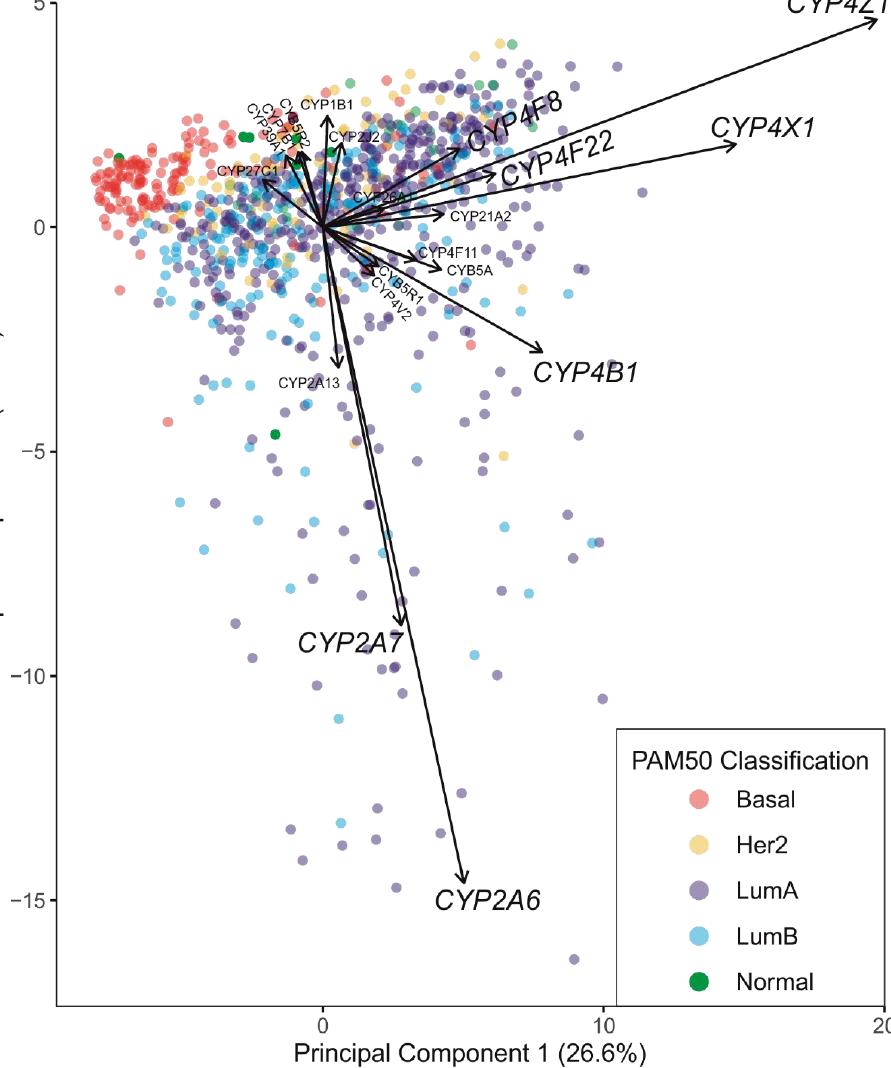
Figure 4. Variance in cytochrome P450 ( CYP ) gene expression (and their essential reductases) was analysed by principal component analysis (PCA). In the PCA biplot, each point represents an individual tumour from The Cancer Genome Atlas (TCGA) breast cancer cohort ( n = 935) coloured according to the PAM50 classification [122]. The size and direction of arrows assigned to the top 20 most variant genes in the cohort represent the PCA loadings and reflect how strongly each gene influences principal components 1 and 2.